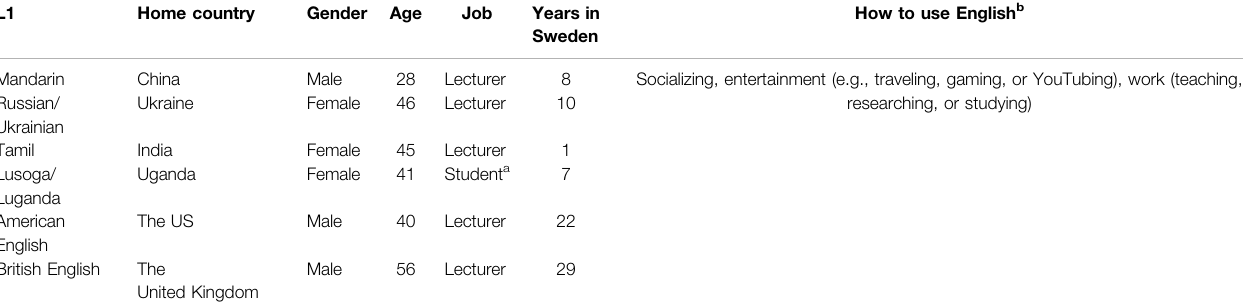
TABLE 1 | Information about speaker